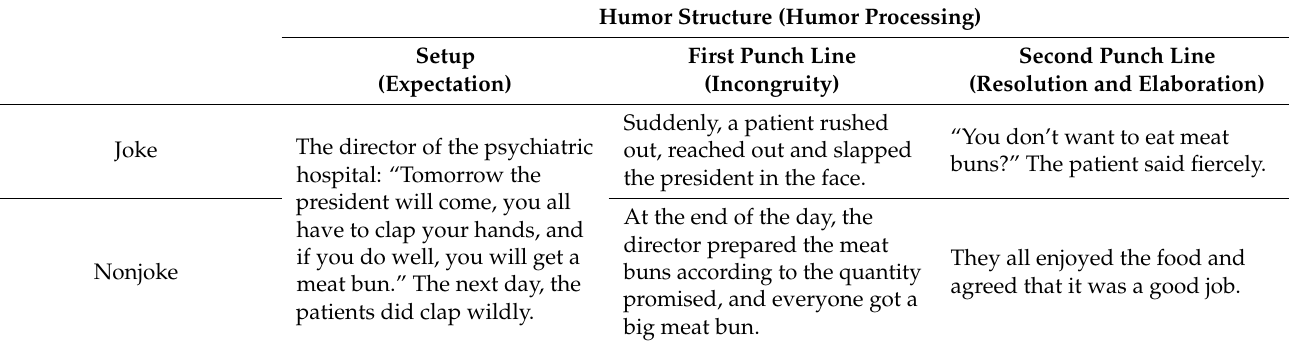
Table 3. An example of a three-element joke and